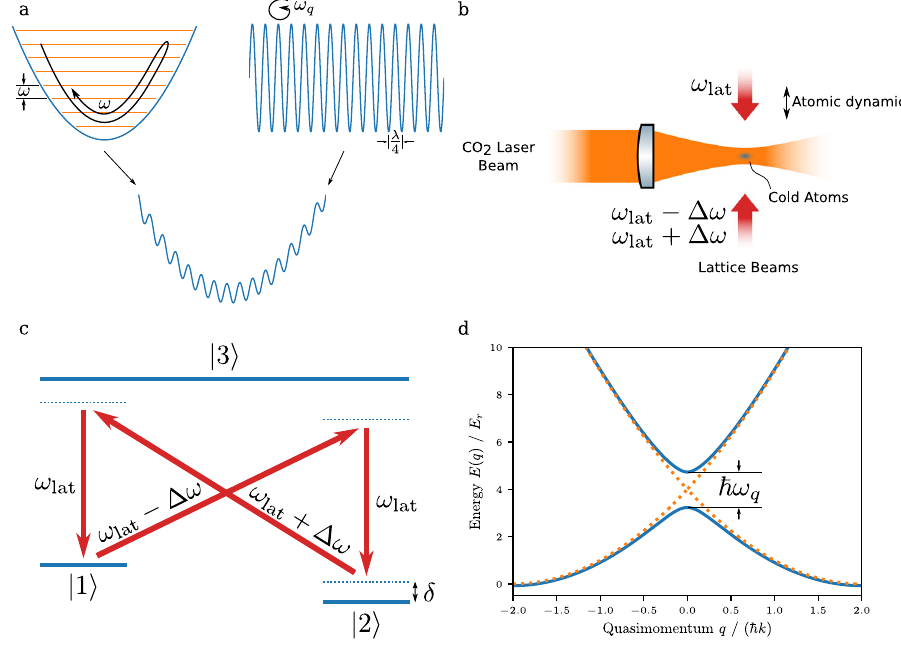
Fig. 1 | Experimental schematic. a Atoms are exposed to the combined potential obtained by superimposing a harmonic trapping potential (left) generated by a focused CO 2 -laser beam and a lattice potential of spatial periodicity λ relevant oscillatory modes, of frequency ω for the oscillation in the harmonic trapping potential and ω q for oscillation at the fi rst band gap of the lattice, are indicated. For atoms moving in the combined potential, the two modes are very strongly coupled. b Schematic of the experimental set-up along with the optical